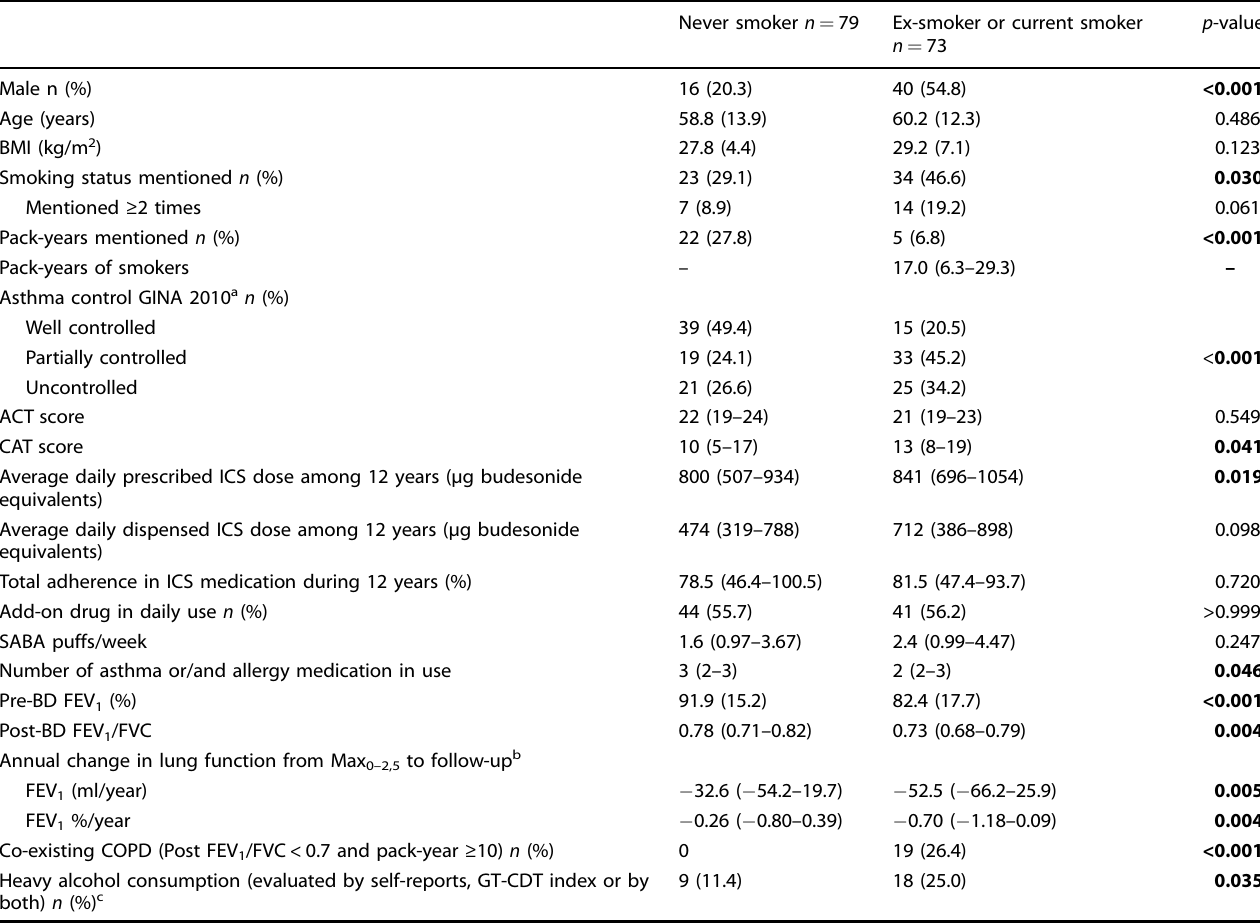
Table 3. The characteristics of the study groups according to the baseline smoking status at 12-year follow-up